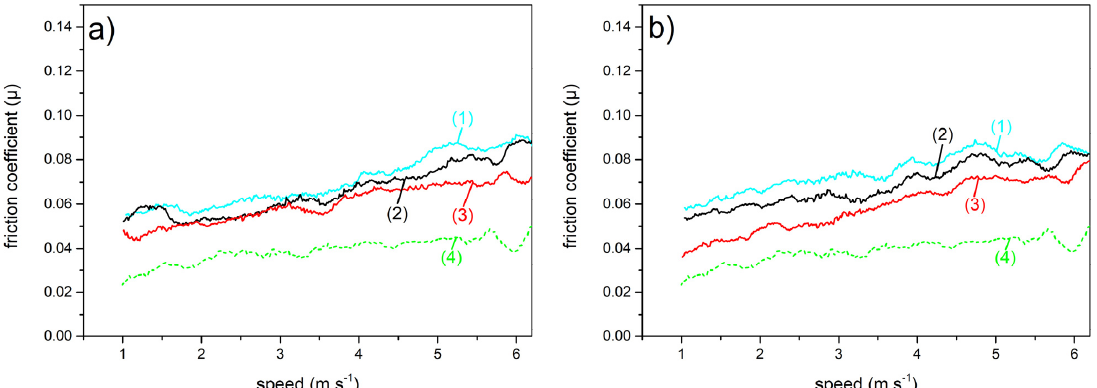
Figure 5. Friction coefficient of AISI 301H, laser engraved, as a function of the gliding speed on snow at different temperatures: − 10 °C (cyan curve, 1); − 5 °C (black curve, 2); − 3 °C (red curve, 3). For comparison, the µ trend for parallel gliding at − 3 °C of stone grinded and waxed UHMWPE (dashed green curve, 4) is shown; ( a ) parallel gliding; ( b ) perpendicular gliding.